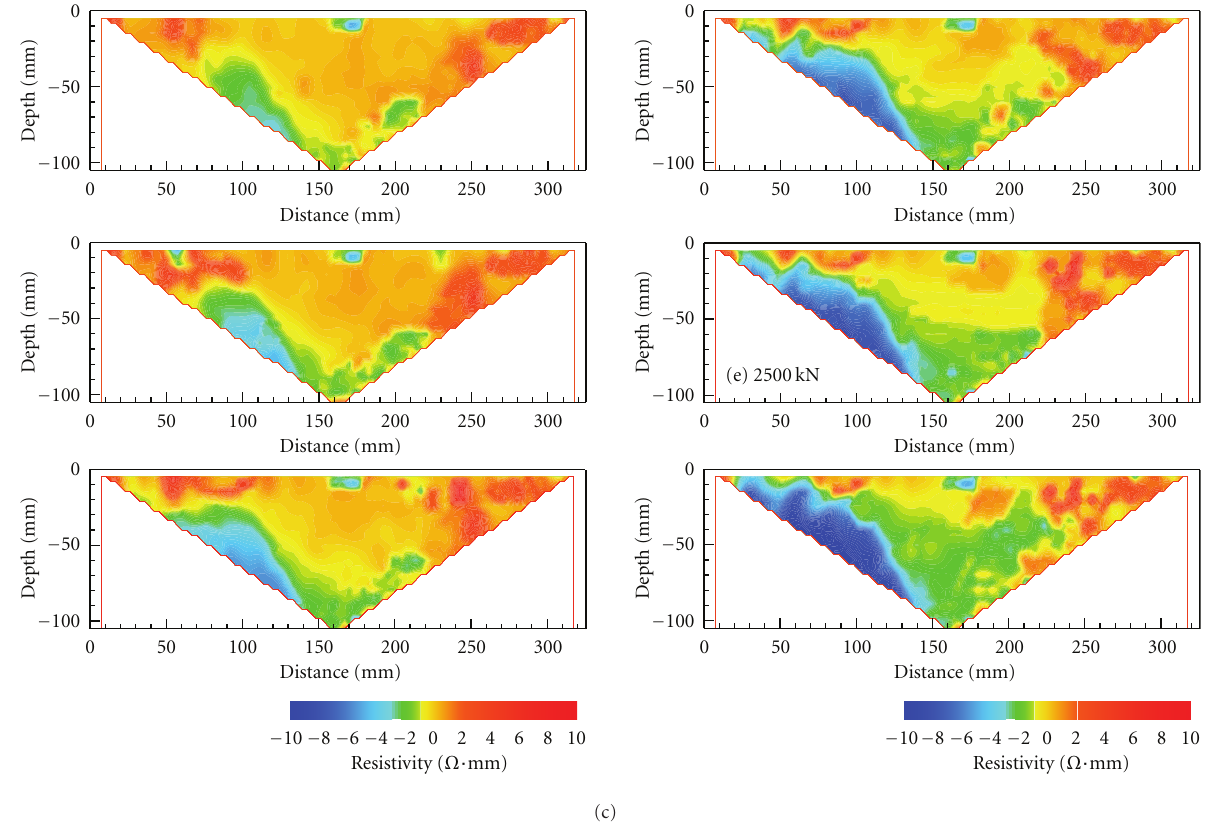
Figure 5: The residual resistivity images of sample YN2. (a) Line 1, (b) Line 2, and (c) Line